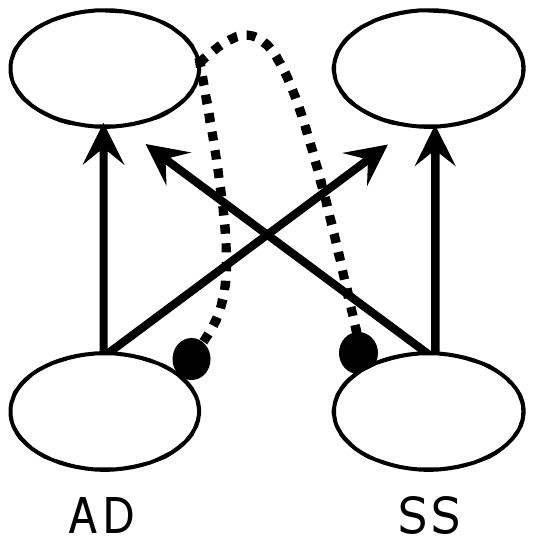
PCA network architecture.Two input units (one corresponding to AD, one to SS) are fully connected to two output units via feed-forward excitatory weights (solid arrows) without any hidden layer or bias. The first output unit projects inhibitory weights (dashed lines) back to the inputs, effectively removing the principal component from the inputs and leaving the second output to encode remaining (orthogonal) covariance. Euclidean distances among output patterns were calculated after each epoch.